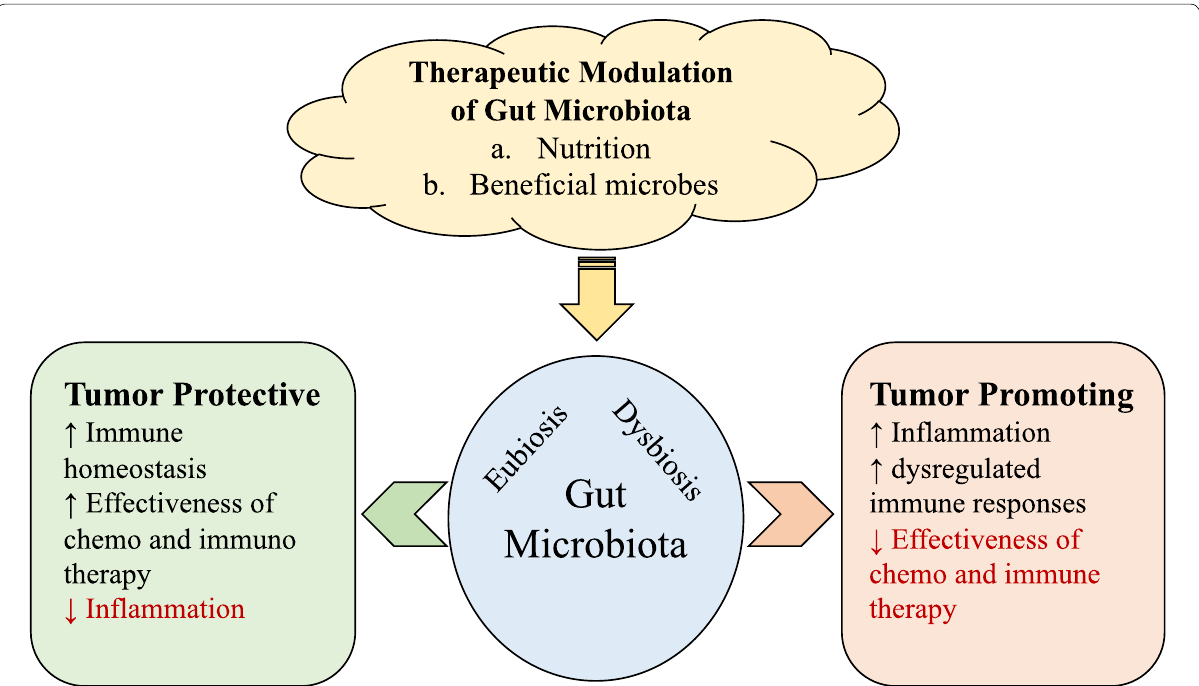
Fig. 4 Role of gut microbiota in tumor progression/protection. Gut microbiota affects systemic inflammation, immune homeostasis and immune regulation. Therefore, eubiosis or dysbiosis of gut microbiota plays a significant role in protection from tumor growth or tumor progression, respectively. Furthermore, effectiveness of chemo- and immuno-therapy approaches is also at least partly governed by the state of gut microbiota. Modulation of gut microbiota through nutrition or ingestions of beneficial microbes may serve as important therapeutic modalities for cancer treatment alone or as an adjunct to chemo- and/or